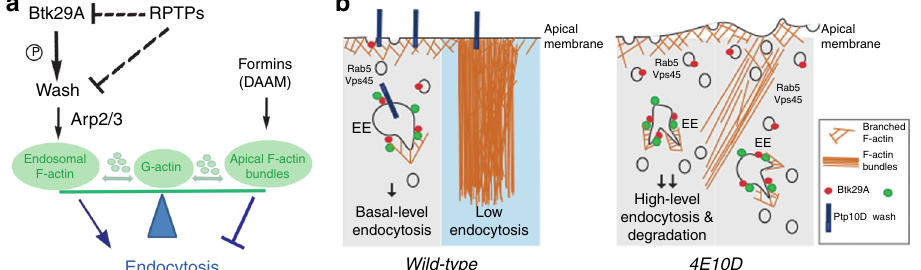
Fig. 9 Receptor protein tyrosine phosphatase (PTP) and Btk regulation of F-actin network integrities. a Schematic representation of the interplay between PTPs, Btk29A and WASH (Wiskott – Aldrich syndrome protein and SCAR homologue) in endocytosis. Btk29A promotes WASH activation by tyrosine phosphorylation while PTPs directly or indirectly antagonizes WASH. Active WASH induces the formation of endosomal actin patches via the Arp2/3 complex and promotes endocytosis. By contrast, DAAM and formins generate apical/cortical actin bundles 12 and maintain steady-state levels of endocytosis. The model proposes a direct competition between the WASH-Arp2/3 and formin-mediated polymerization modes for a globular actin pool (G-actin). b Cartoons showing the function of PTPs/Btk29A/WASH and actin bundles during luminal protein clearance in wild-type and Ptp4EPtp10D .